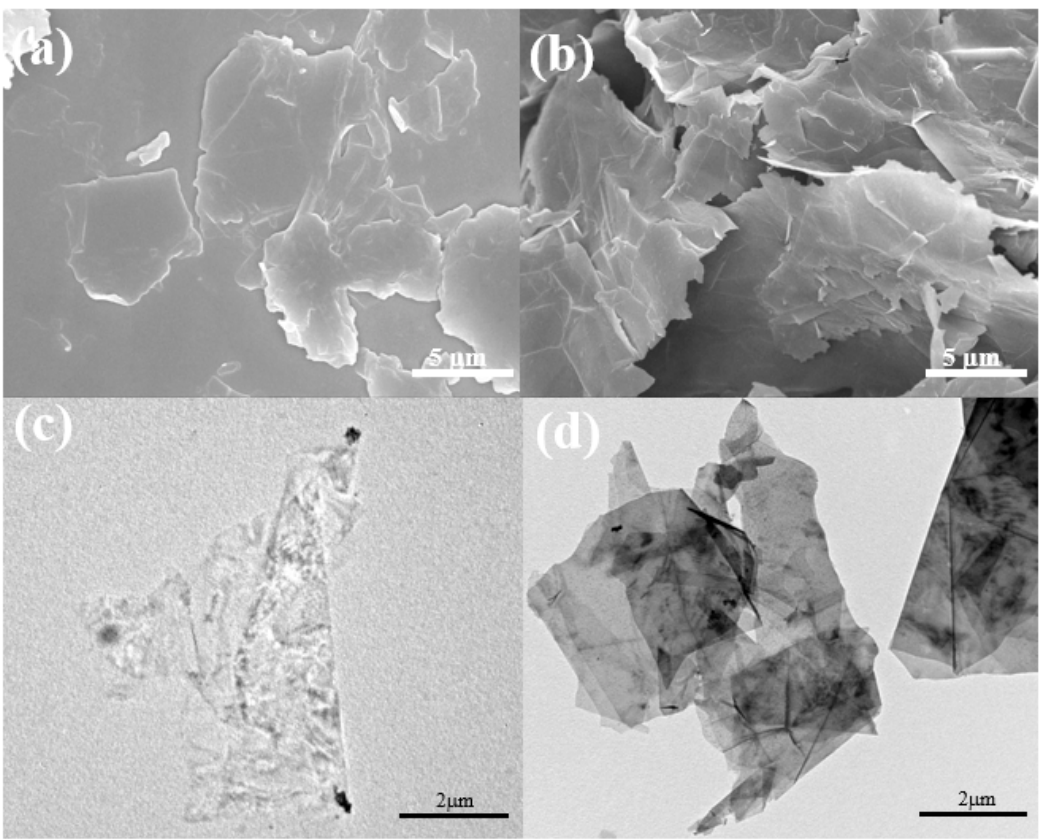
Figure 2. SEM images of di ff erent graphene sheet sizes: ( a ) GN-13 and ( b ) GN-28, and transmission electron microscopy (TEM) images of di ff erent graphene sheet sizes: ( c ) GN-13 and ( d ) GN-28. Polymers 2020 , 01 , x FOR PEER REVIEW